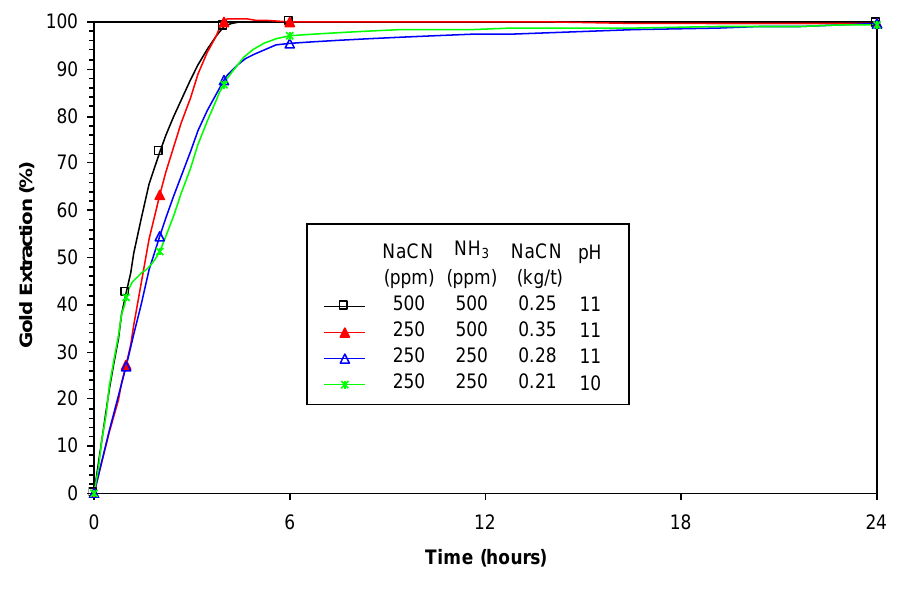
Figure 11. Effect of cyanide and ammonia on gold extraction in presence of chalcopyrite; 0.3% Cu, 8 ppm